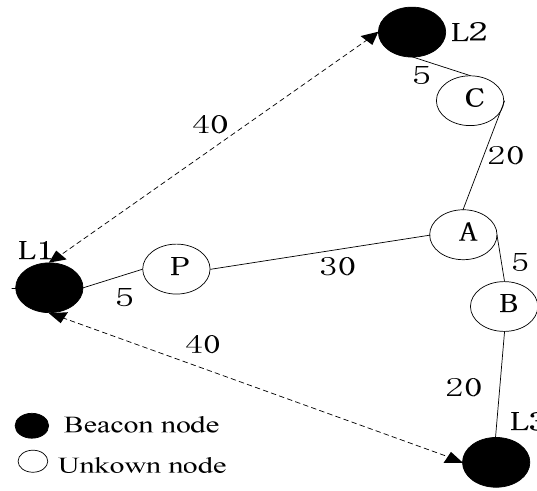
Figure 1. Error Analysis.